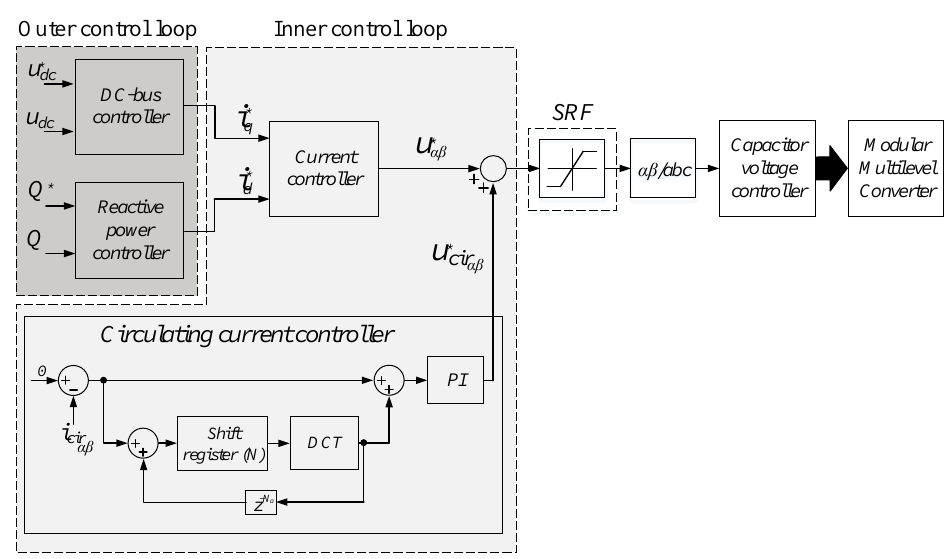
Figure 18. Overall control scheme based on repetitive controller.